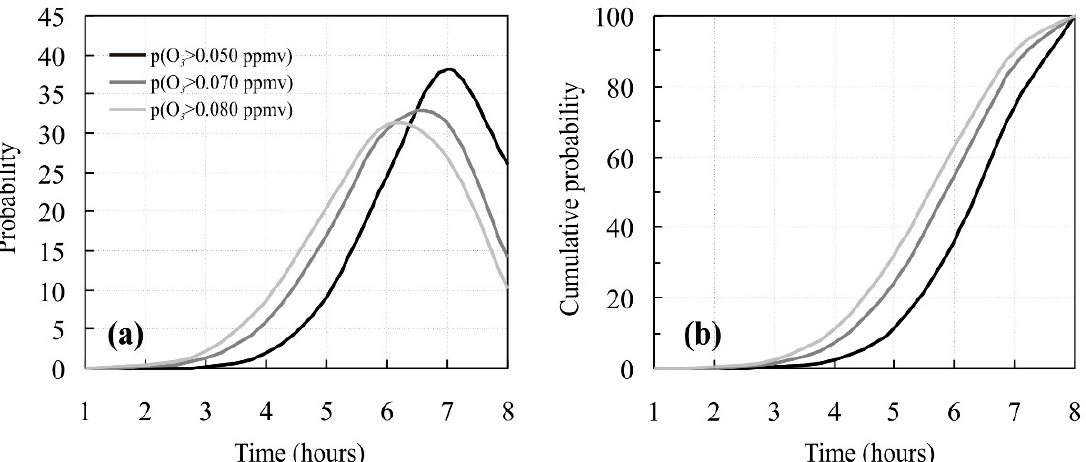
Figure 8. ( a ) The statistical probability of the ozone above some maximum permissible limits as a function of the number of hours for a given event. ( b ) Cumulative probability of the integrated temporal window.